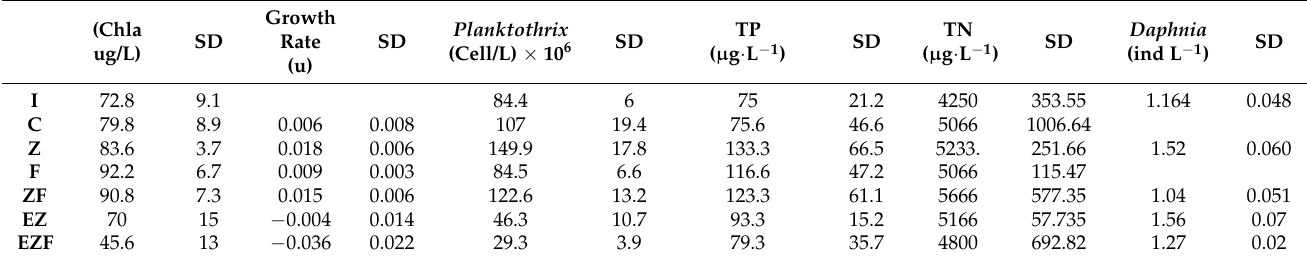
Table A3. Phytoplankton biomass, growth rate, Planktothrix density, and Daphnia density in the treatments of fish (F) and large zooplankton (Z) after 12